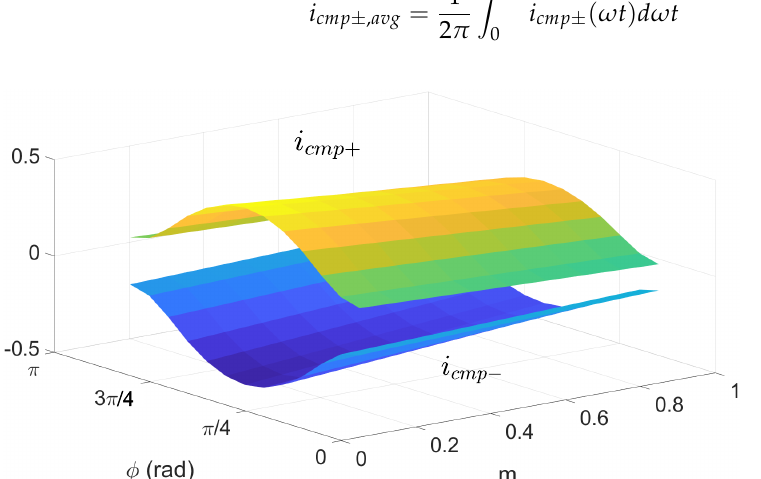
Figure 15. Average positive and negative compensating currents under different power factors and modulation